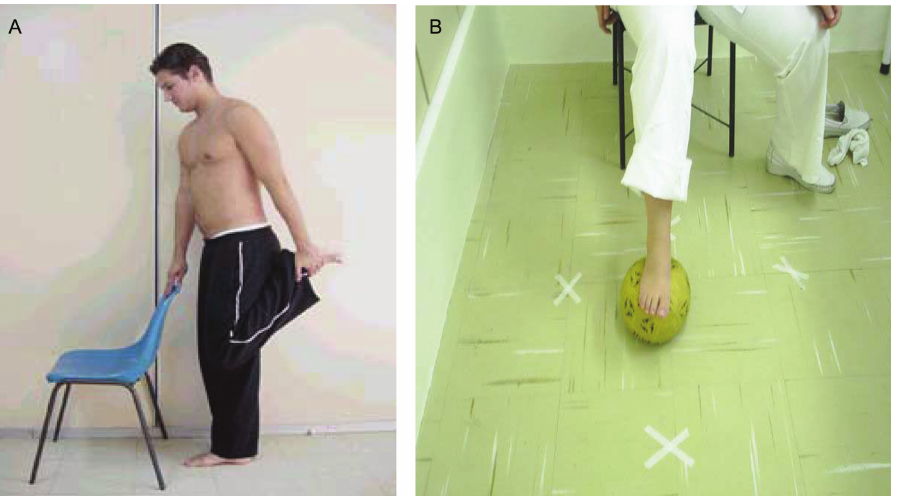
Figure 1 - Examples of two exercises proposed in the Manual, and their accompanying photographs. (A) While standing, hold on to a chair or table to maintain your balance, bend one of your knees and with your hand, pull your foot towards your bottom.. If you cannot reach your foot, pull it with the help of a folded towel. (B) Mark the floor with adhesive tape in various directions. Sit down on a chair, step on a ball and roll it to the markings made on the floor. Repeat 10